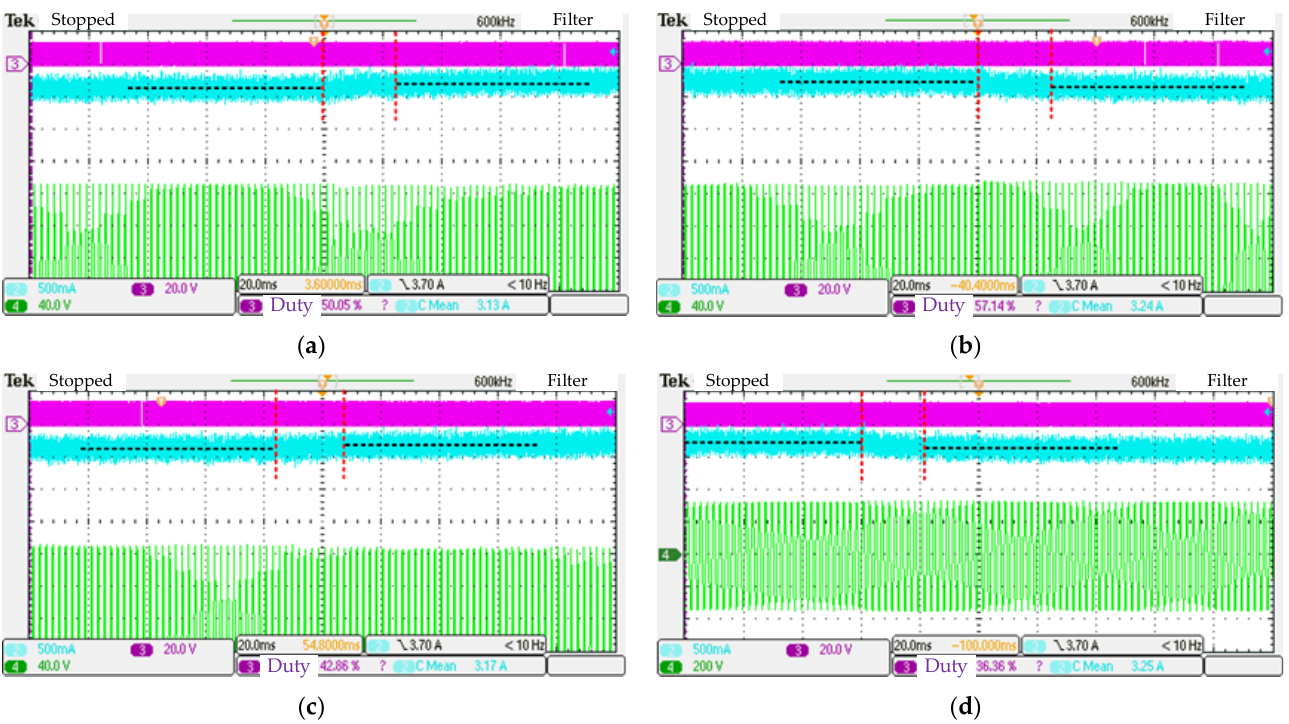
Figure 17. Dynamic performance of the generator system: ( a ) suddenly loaded at 6795 r/min; ( b ) suddenly unloaded at 6795 r/min; ( c ) suddenly loaded at 7500 r/min; ( d ) suddenly unloaded at 7500 r/min.